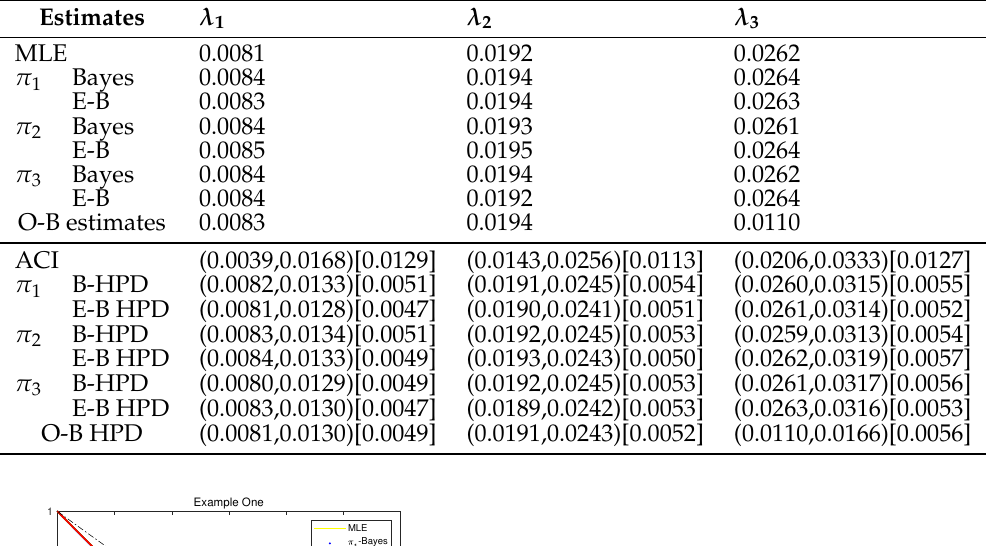
Table 6. Point and interval estimates of MOBE parameters for dependent electric power transformers’ competing risks data